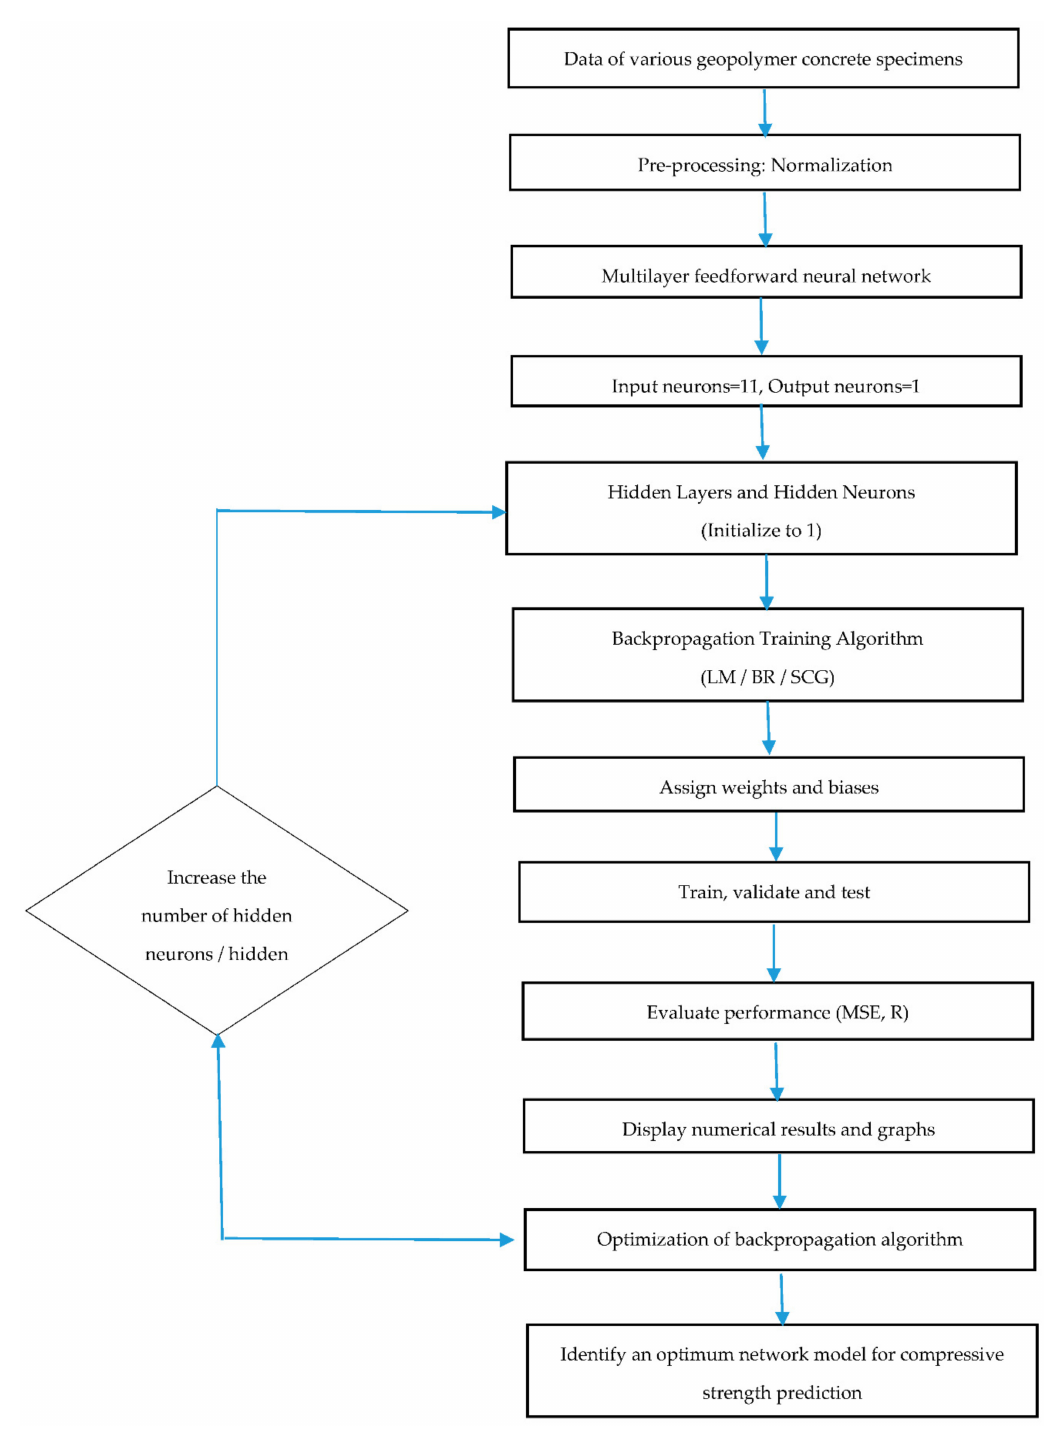
Figure 3. Step-by-step procedure to predict the compressive strength of geopolymer